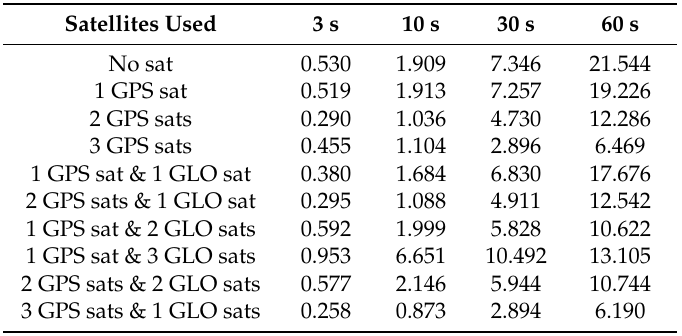
Table 1. Summary of horizontal errors using different satellites. GLO: GLONASS; sat: satellite. Table 2. 3D position errors in short time for the first dataset (unit: